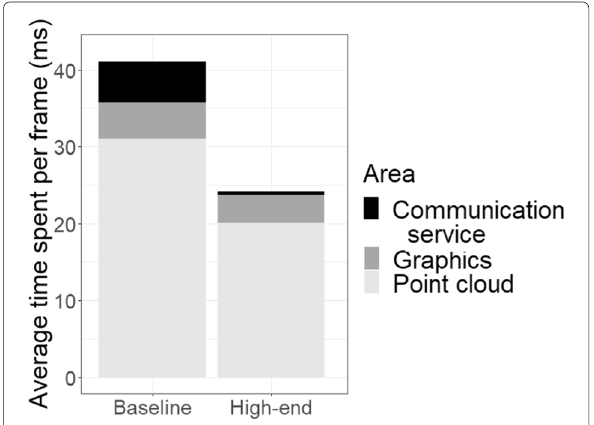
Fig. 5 Latency breakdown of the MR-related edge processing for different